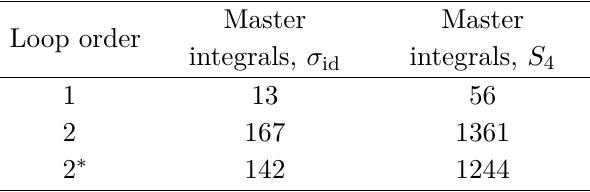
Table 2. Number of independent one- and two-loop master integrals in the unions of integral (cid:8) (cid:9) families { 1L } and mzz , zmz , zzz , 1L 2 respectively. The second column corresponds to the